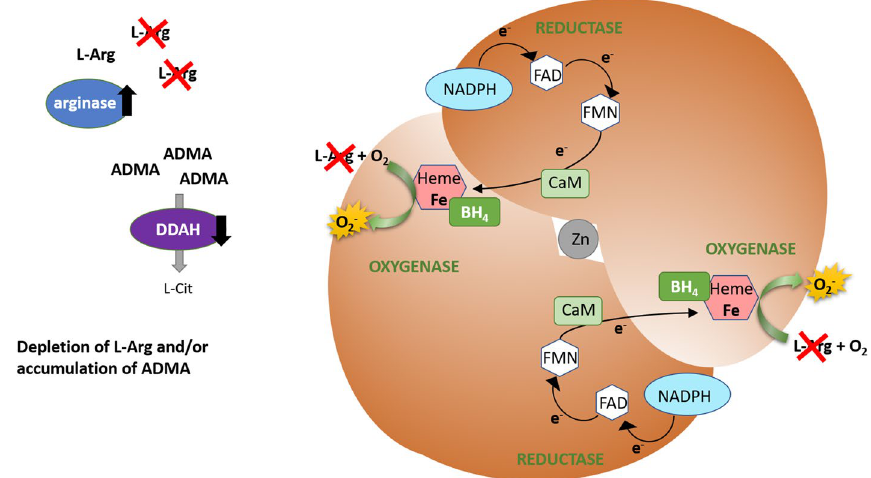
Fig. 3 eNOS uncoupling due to diminished L‑Arg/ADMA ratio. Under reduced L‑Arg availability (resulting from excessive arginase activity) and/or accumulation of ADMA (due to decreased DDAH activity), the substrate concentration may not be sufficient to saturate eNOS and/or L‑Arg is outcompeted by ADMA. As a result, molecular oxygen is a final electron acceptor, leading to superoxide